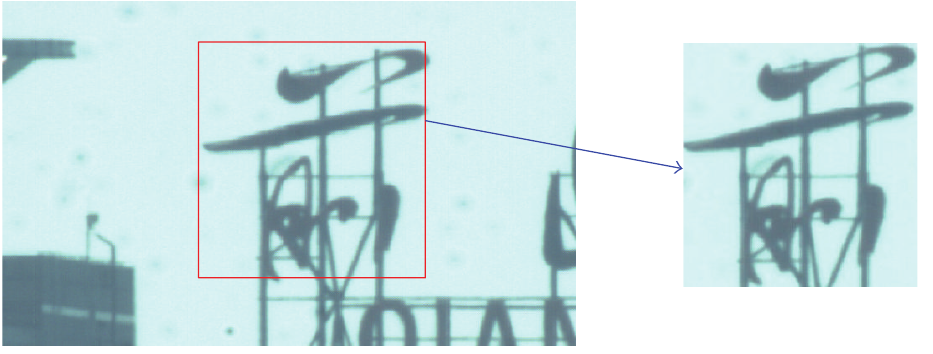
Figure 3: Extraction of the target image to be matched.